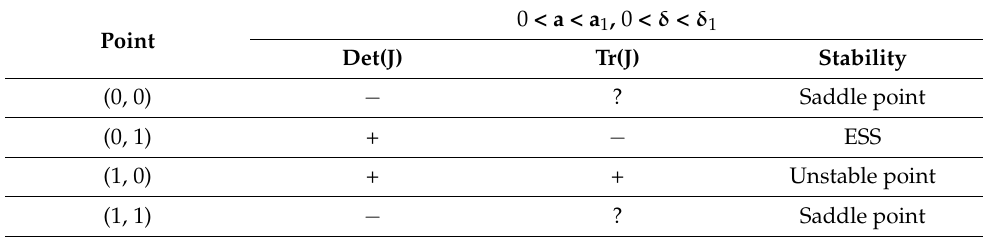
Table 8. Stability analysis of the points in case (2).